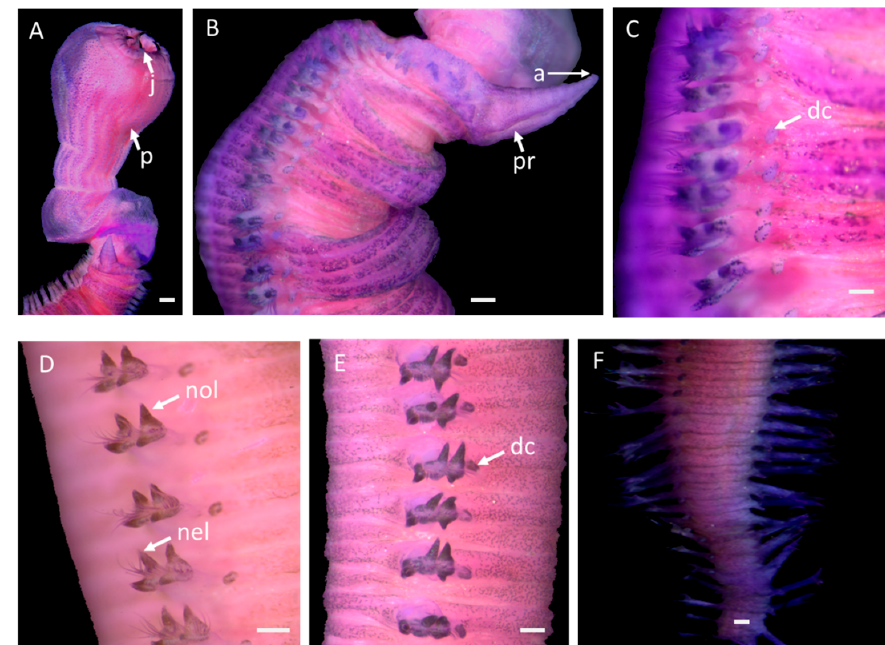
Figure 2. Glycera sheikhmujibi n. sp.: ( A ) anterior dorsal view, ( B ) anterior lateral view, ( C ) lateral view of anterior chaetigers, ( D ) mid-body chaetigers, ( E ) lower mid-body chaetigers, ( F ) posterior chaetigers. j; jaw, a: antenna, p: proboscis, pr: prostomium, dc: dorsal cirri, nol = notopodial lobe, nel = neuropodial lobe; scale bars: 0.1 mm.